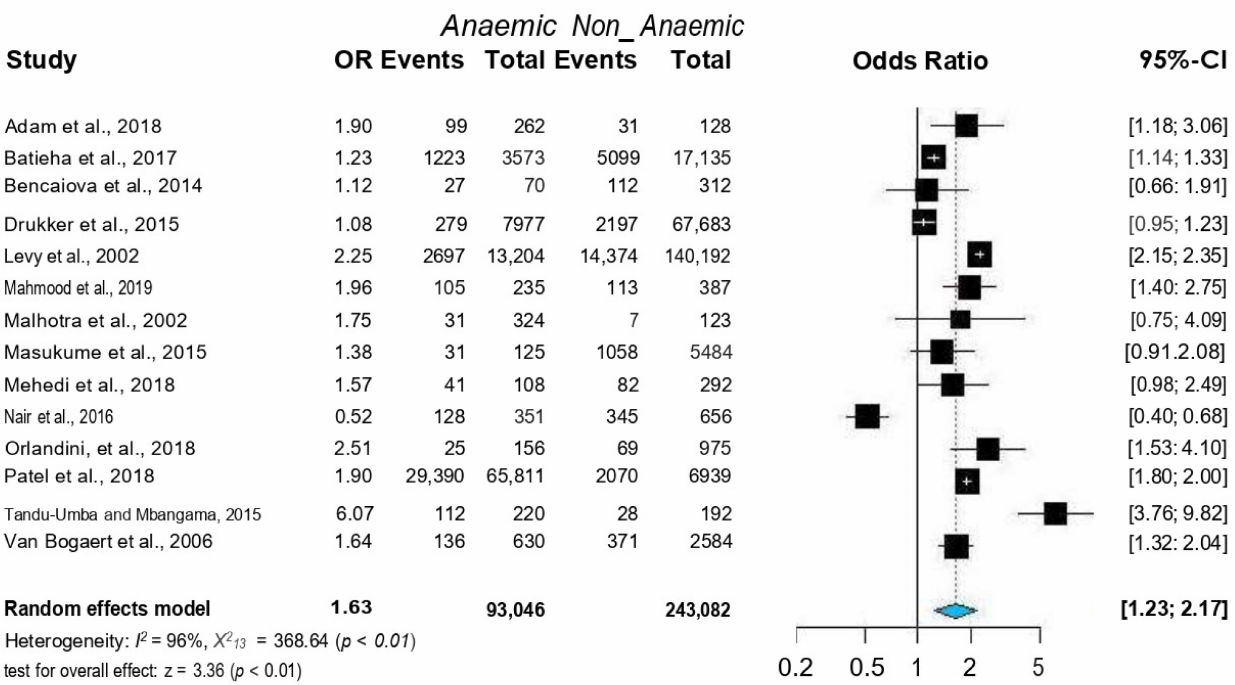
Figure 3. Forest plots of ORs with 95% CIs of the meta-analysis of anaemia and caesarean delivery. Published data from Adam et al. [27], Batieha et al. [25], Bencaiova et al. [26], Drukker et al. [10], Levy et al. [6], Mahmood et al. [28], Malhotra et al. [19] Masukume et al. [8] Mehedi et al. [20] Nair et al. [24] Patel et al. [9] Orlandini et al. [21] Tandu-Umba et al. [22] and Van Bogaert et al. [23] were used to calculate the pooled OR.